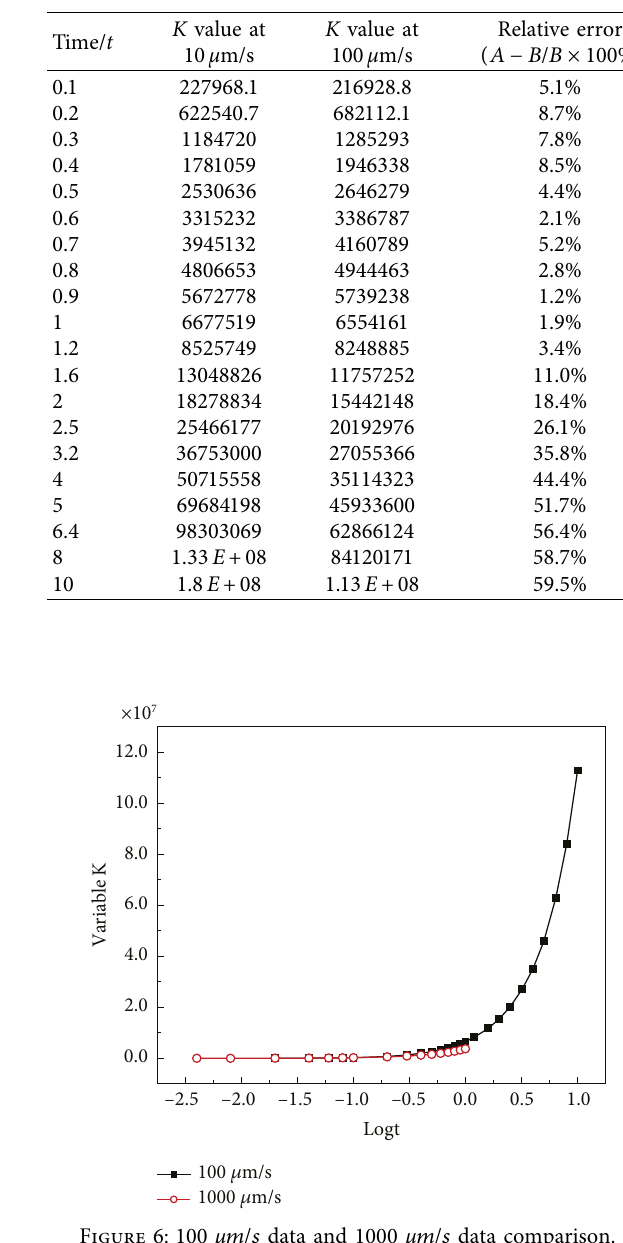
Table 1: Detailed comparison of 10 μ m/s data and 100 μ m/s data.